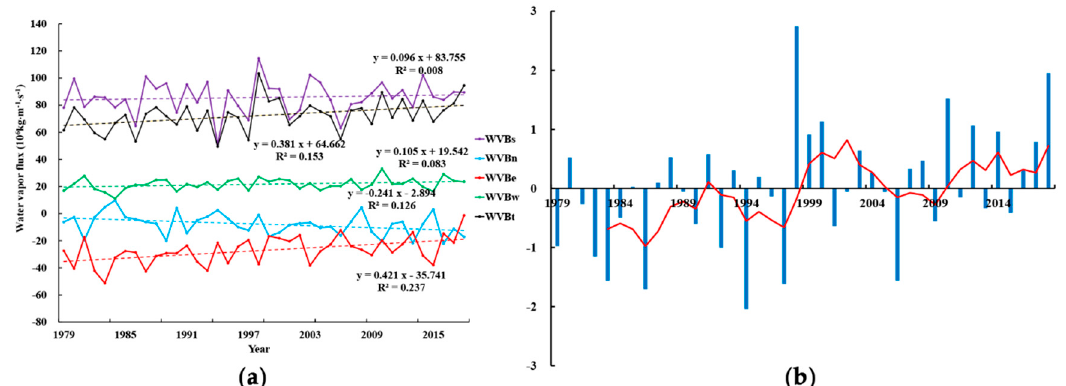
Figure 5. ( a ) Summer water vapor budget (WVB) (unit: 10 6 kg s − 1 ) at different boundaries of the TP from 1979 to 2018, WVB n (blue, northern boundary), WVB w (green, western boundary), WVB s (purple, southern boundary) and WVB e (red, eastern boundary) represent the WVBs of the four boundaries; ( b ) the standard time series of summer WVB t (blue column) and its 11-year moving average (red line).